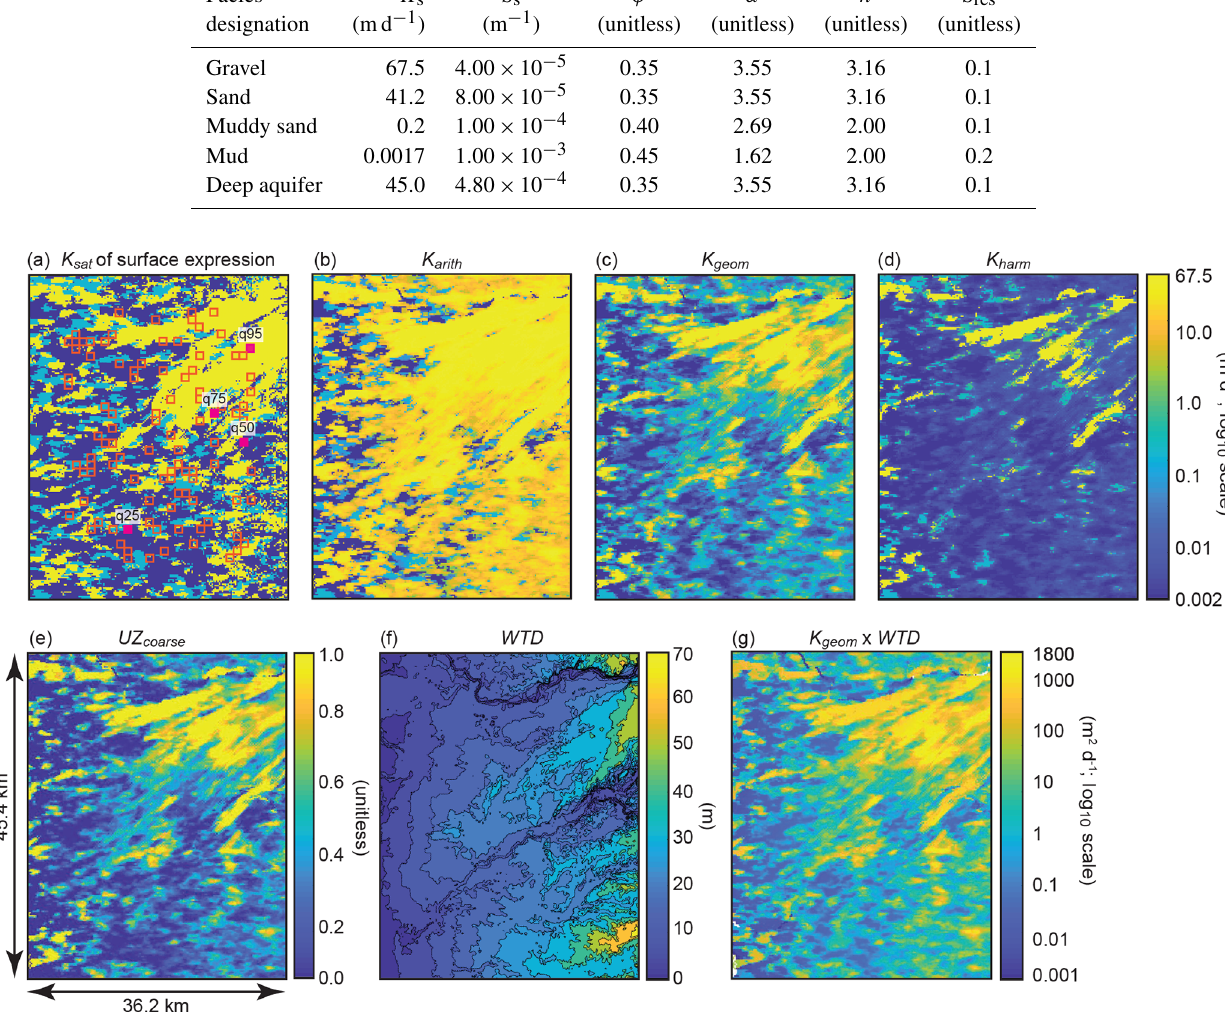
Figure 3. Plan view of the model domain, where the first row shows (a) K sat of the uppermost model layer (i.e., the surface expression) overlaid with the locations of 100 randomly sampled 1km 2 exploratory recharge sites (red squares) randomly chosen from 910 potential locations as well as the four sites chosen for sensitivity analyses (q95, q75, q50, and q25; solid violet squares), along with the (b) arithmetic, (c) geometric, and (d) harmonic mean of vertical K sat for unsaturated-zone (UZ) facies (i.e., K arith , K geom , and K harm , respectively). The second row shows (e) the coarse-texture (gravel and sand) fraction of UZ facies (UZ coarse ), (f) the simulated initial depth to water (WTD), and (g) K geom multiplied by WTD ( K geom × WTD). Locations > 5km from the lateral domain boundaries were excluded from the potential sites to avoid interference with boundary